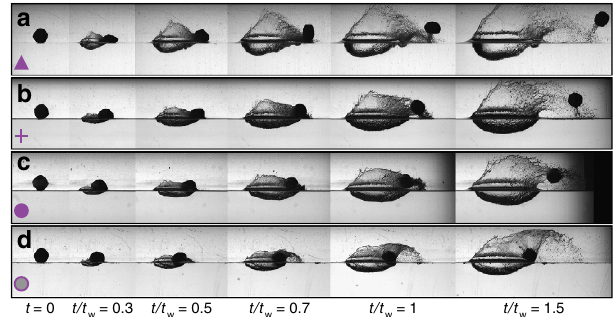
R d = s . Thus, shear modulus G for ¼ r w U 2 o n n and e 2 decrease n t